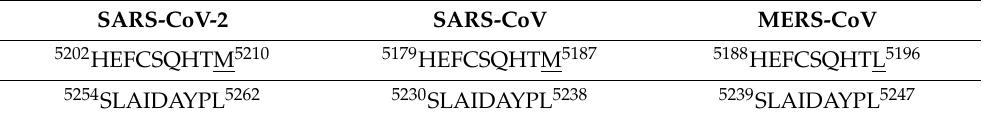
Table 7. Conservancy analysis of conserved Epitopes in SARS-CoV-2 against SARS-CoV and MERS- CoV which belong to the same Betacoronavirus family. The different residue is